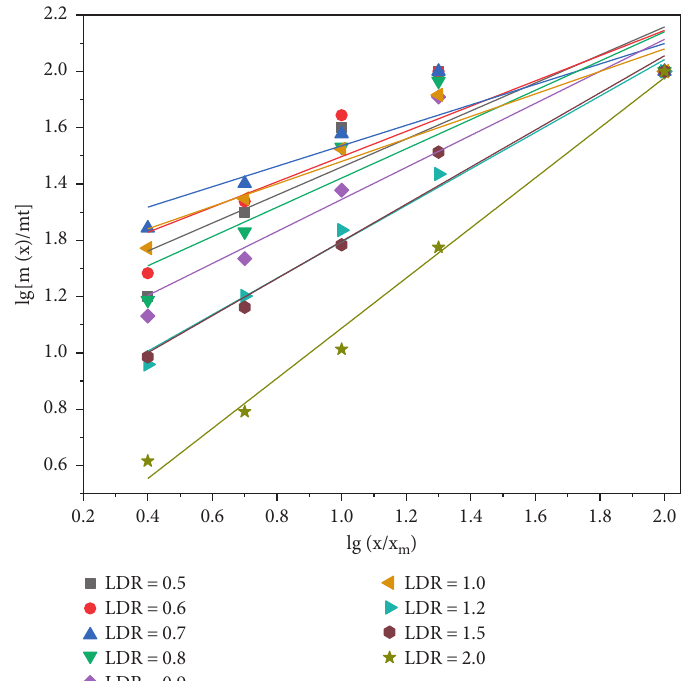
Figure 6: lg [ m ( x ) / m ] − lg x / x t m curve of fragmentation distribution of different length-to-diameter